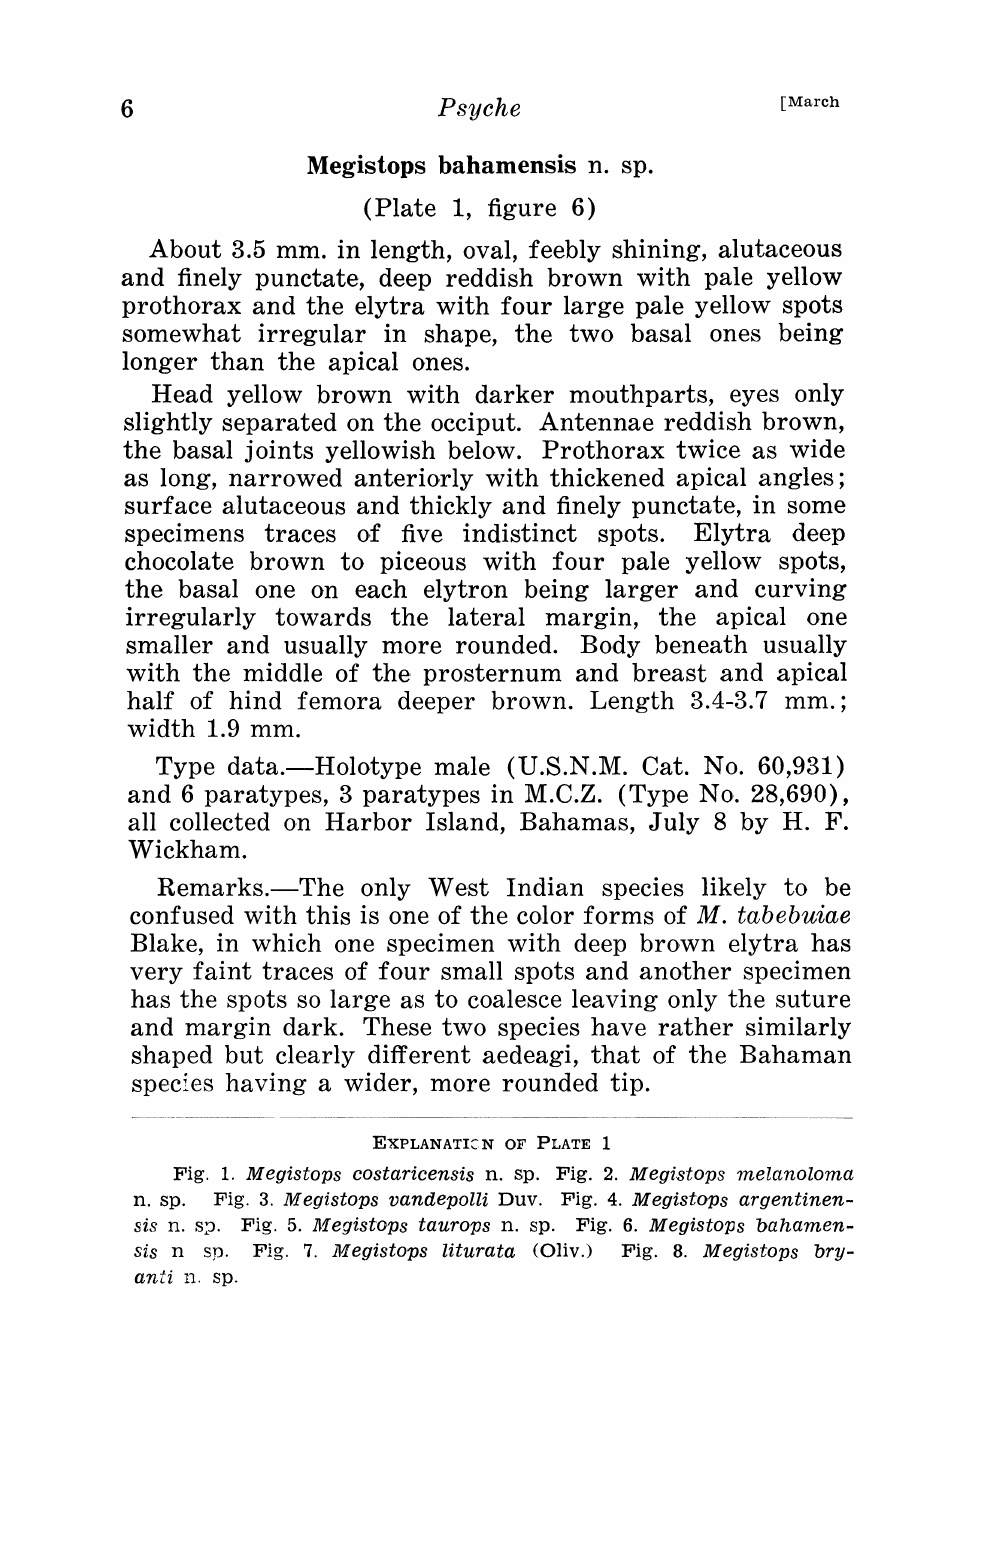
Fig. 1. Megistops costaricensis n. sp. Fig. 2. Megi.stops melanoloma n. sp. Fig. 3. Megistops vandepolli Duv. Fig. 4. Megistops argentinen- sis n. sp. Fig. 5. Megistops taurops n. sp. Fig. 6. Megistops bahamen- sis n sp. Fig. 7. Megistops liturata (Oliv.) Fig. 8. Megistops bry- anti n.